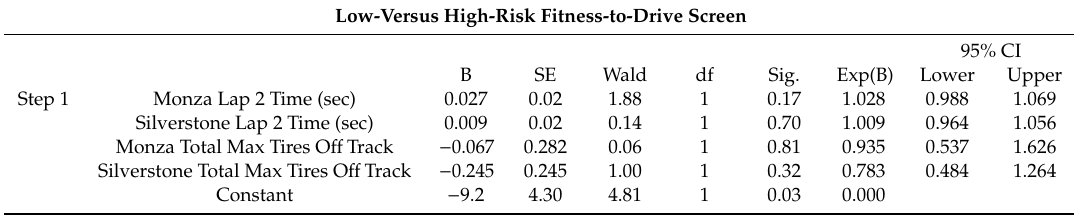
Table 10. Racing simulator variables in the binary logistic regression Model